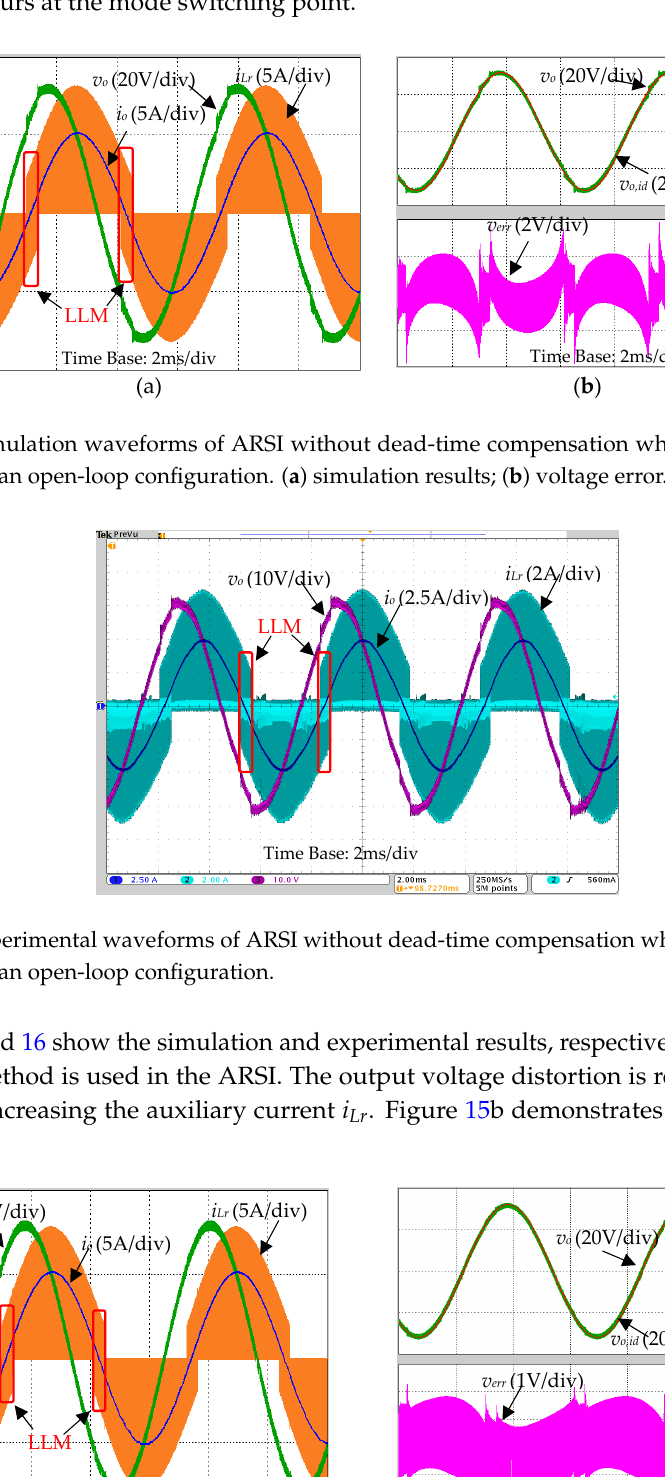
Figure 15. Simulation waveforms of ARSI with dead ‐ time compensation when the modulation index is 0.4 in an open ‐ loop configuration. ( a ) simulation results; ( b ) voltage error.